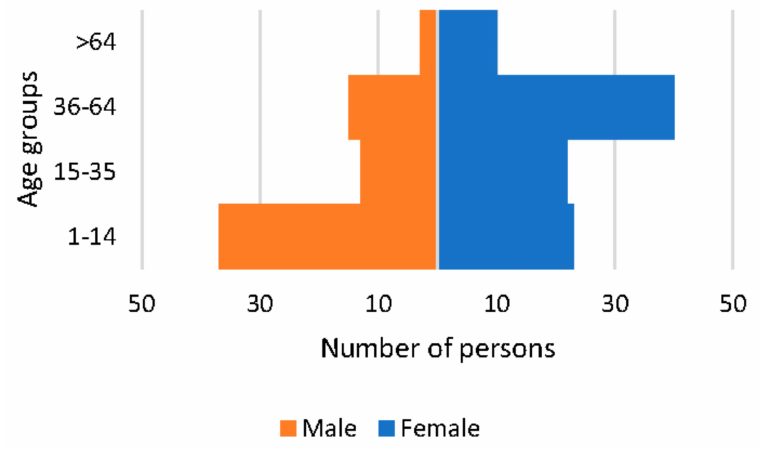
Figure 1. Distribution of patients by sex and age